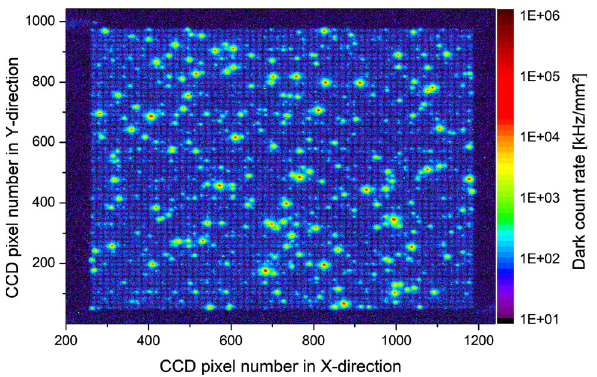
Fig. 18 Dark count rate map of the PM3350T STD at Δ V = 5 . 4 V and t exp = 1 h. One CCD pixel corresponds to 10 . 43 µ m 2 of the SiPM area